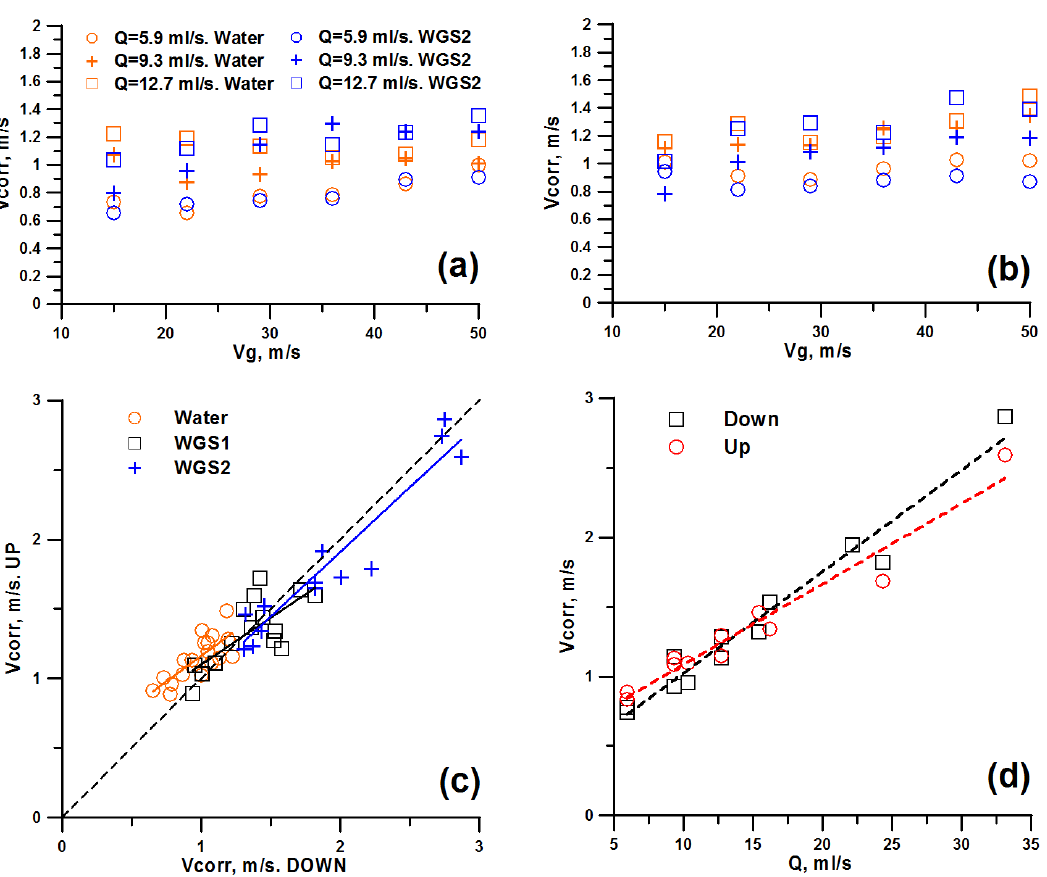
Figure 6. Phase velocity of the initial waves. ( a , b ) The effect of liquid viscosity at a fixed liquid flow rate for downward ( a ) and upward ( b ) flows. ( c ) The effect of flow orientation. ( d ) The effect of a liquid flow rate for a fixed gas velocity, V G = 29 m/s.